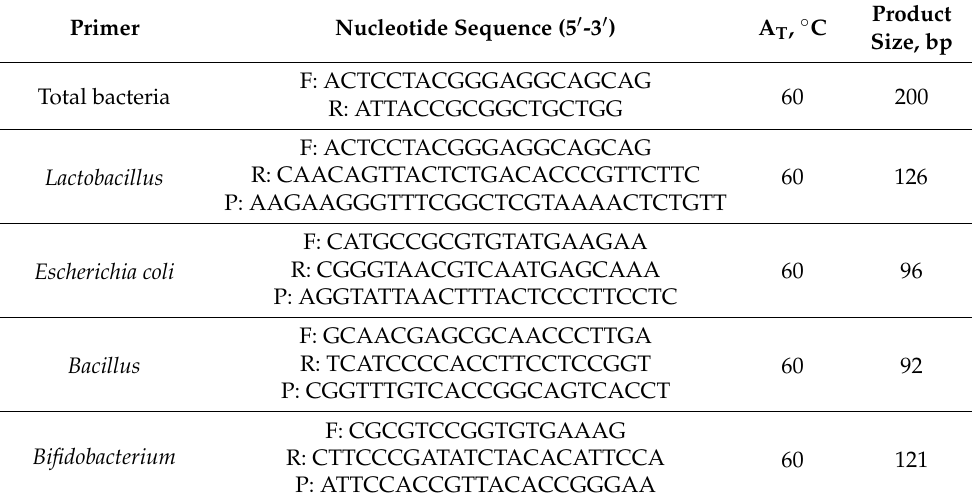
Table 2. Sequence of primers and probes used for the real-time PCR analysis of microbial populations.